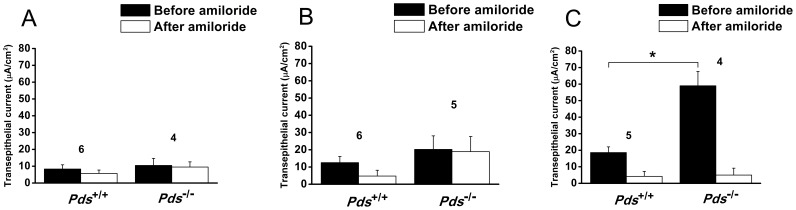
Differences of trans-epithelial current in Reissner’s membrane at P0 (A), P6 (B), and P56 (C).Cation absorption or anion secretion current was detected in Pds+/+ and Pds−/− mice at P0 and P6 and was not significantly inhibited by 10 µM amiloride. The current was not significantly different between Pds+/+ and Pds−/− mice. However, amiloride-sensitive current was detected at P56, and the current was significantly increased at P56 in Pds−/− compared with Pds+/+ mice. *p<0.05, numbers above the bars represent the number of trans-epithelial current measurements.